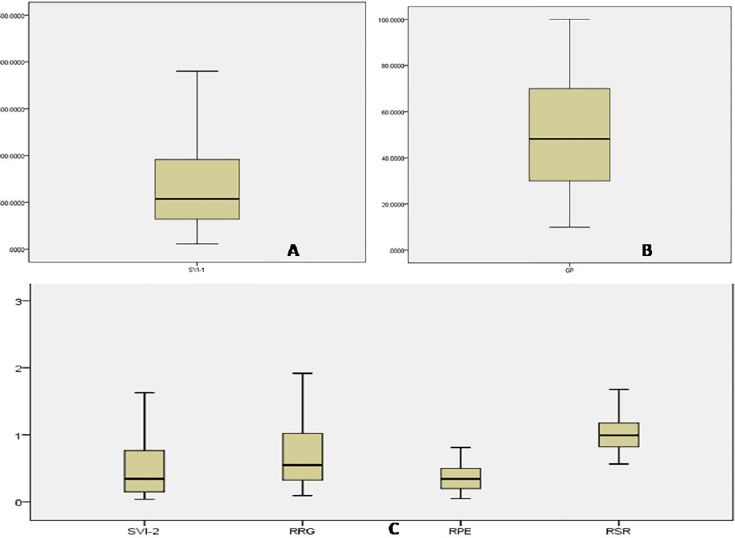
Fig 3. Box plots representing the phenotypic variation in the physiological parameters for (A) Seed vigour index-I (B) Germination %, (C) for Seed vigour index-II, RRG, RPE and RSR in a panel containing 120 rice landraces. https://doi.org/10.1371/journal.pone.0267303.g003 physiological traits estimated from the 120 genotypes present in the panel (Fig 4A). The first and second principal components based on the correlation values showed 47.7.651 and 16.9of the total variability with eigen value of 2.86 and 1.02, respectively. RSR contributed maximum diversity among the 6 physiological parameters followed by SVII and SVI for the panel